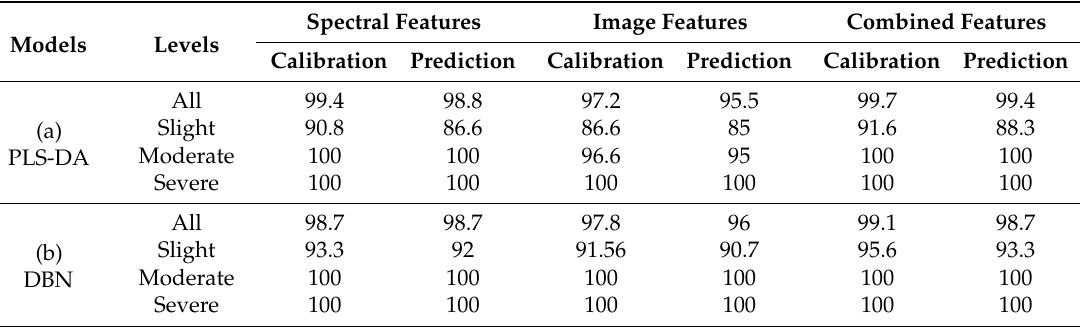
Table 1. The results for the classification of diseased and healthy peaches under three levels of decay, using spectral and image features by PLS-DA and DBN